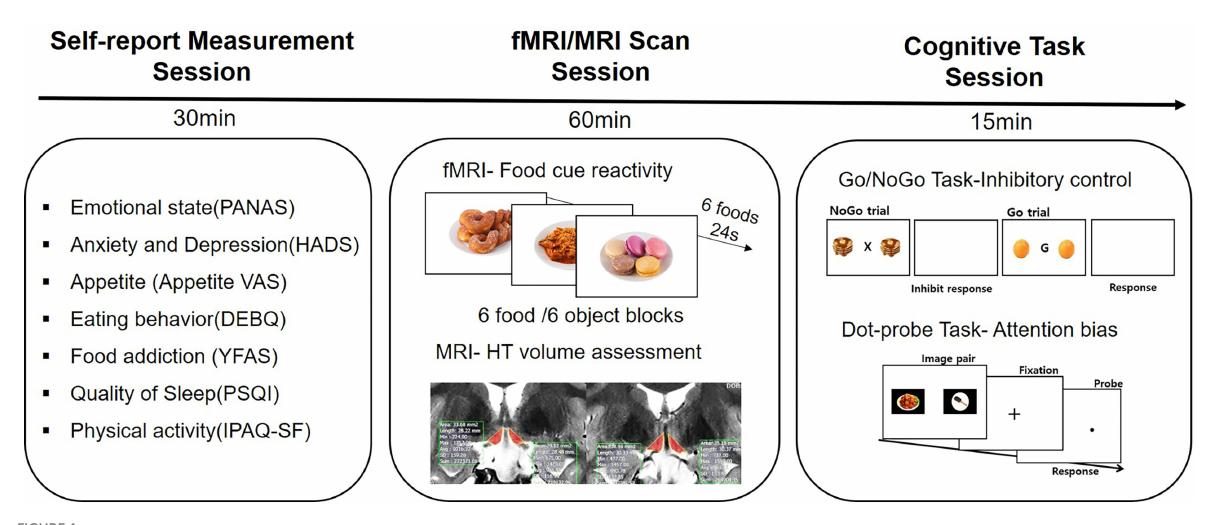
FIGURE 1 Study design. All participants fi lled out self-reported questionnaires for assessing psychological and behavioral phenotypes. They underwent an fMRI scan and a routine follow-up MRI scan. After the MRI scan, two computerized cognitive tasks were